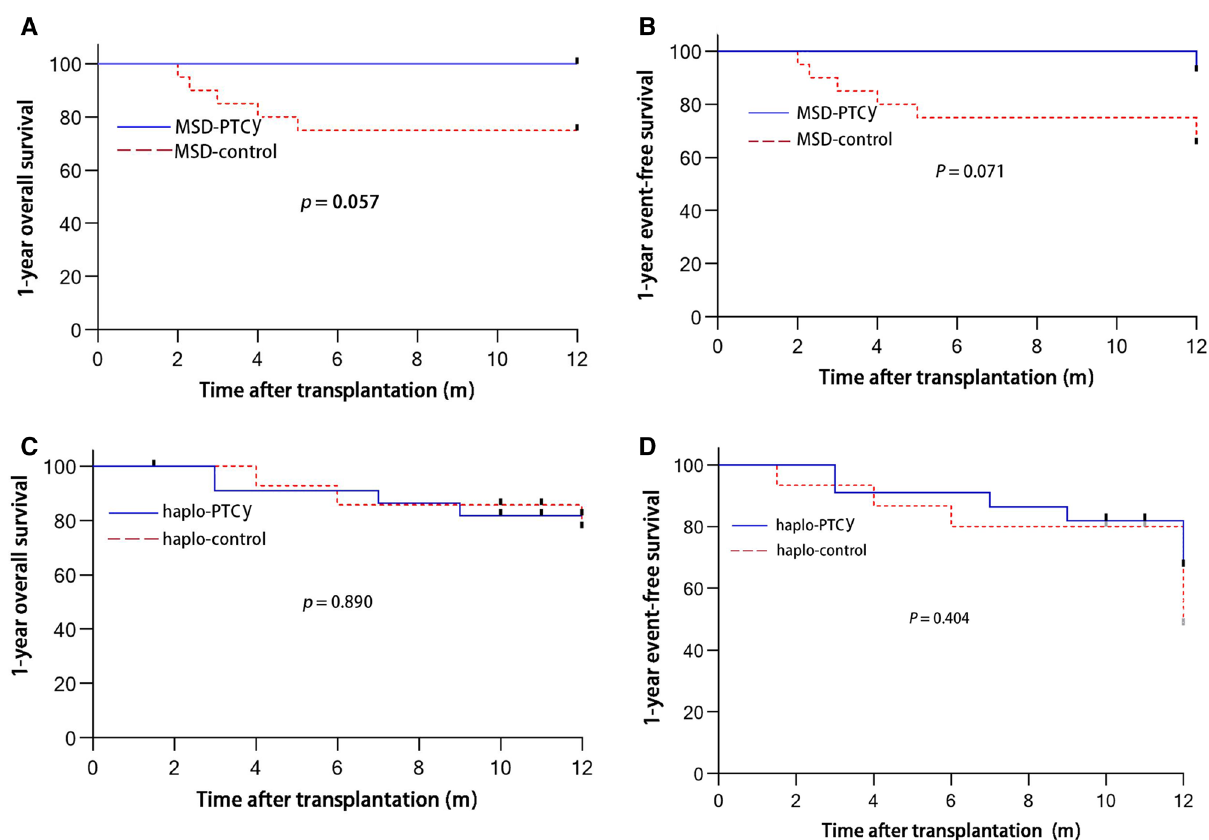
Figure 3. Kaplan–Meier curves for overall survival (OS) and event-free survival (EFS). ( A ) Cumulative percentage of 1-year OS in MSD-PTCy group compared to MSD-control group. ( B ) Cumulative percentage of 1-year EFS in MSD-PTCy group compared to MSD-control group. ( C ) Cumulative percentage of 1-year OS in the haplo-HSCT group compared to haplo-control group. ( D ) Cumulative percentage of 1-year EFS in the haplo-HSCT group compared to haplo-control